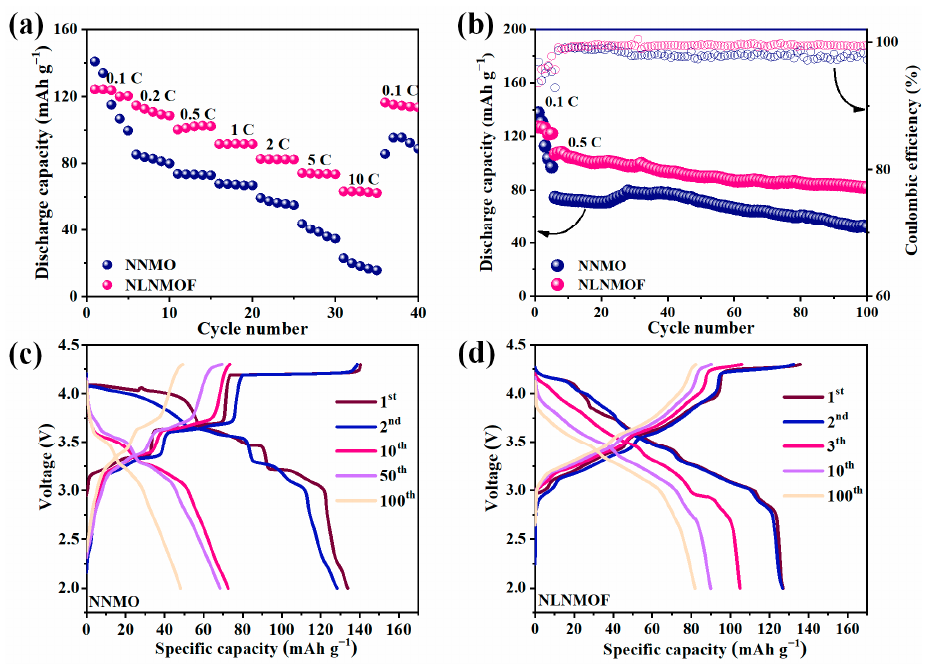
Figure 3. ( a ) Rate and ( b ) cycling performances of NNMO and NLNMOF electrodes between 2.0–4.3 V. The charge–discharge profiles of ( c ) NNMO and ( d ) NLNMOF for the 1st, 2nd, 10th, 50th, and 100th cycle.